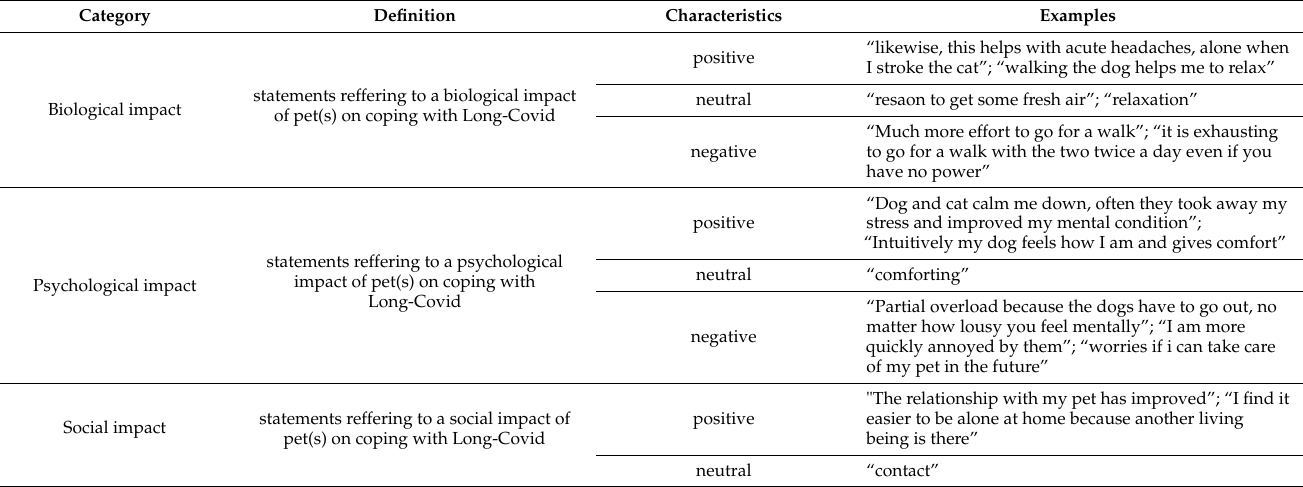
Figure 4. Percentages of pandemic-related concerns within the group “No infection” . Table 11. Deductive categorization regarding the pets role during the pandemic and when one is suffering from Long Covid